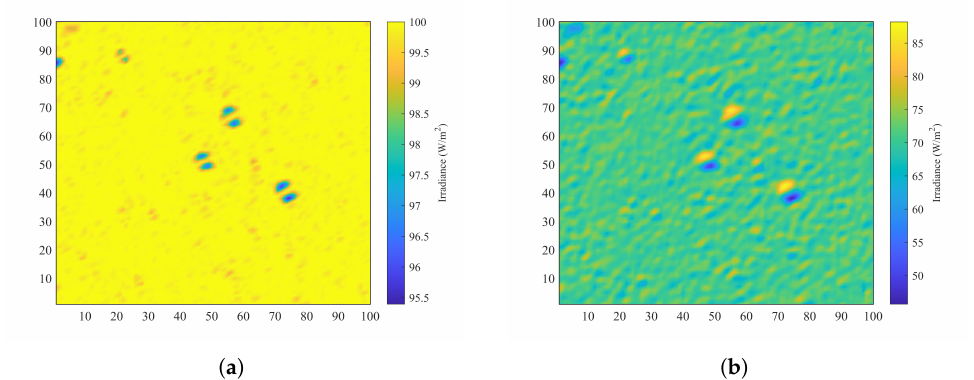
Figure 5. Irradiance distribution of the Chang’e-3 landing area under various solar locations: ( a ) (0 ◦ , 150 ◦ ) and ( b ) (45 ◦ , 150 ◦